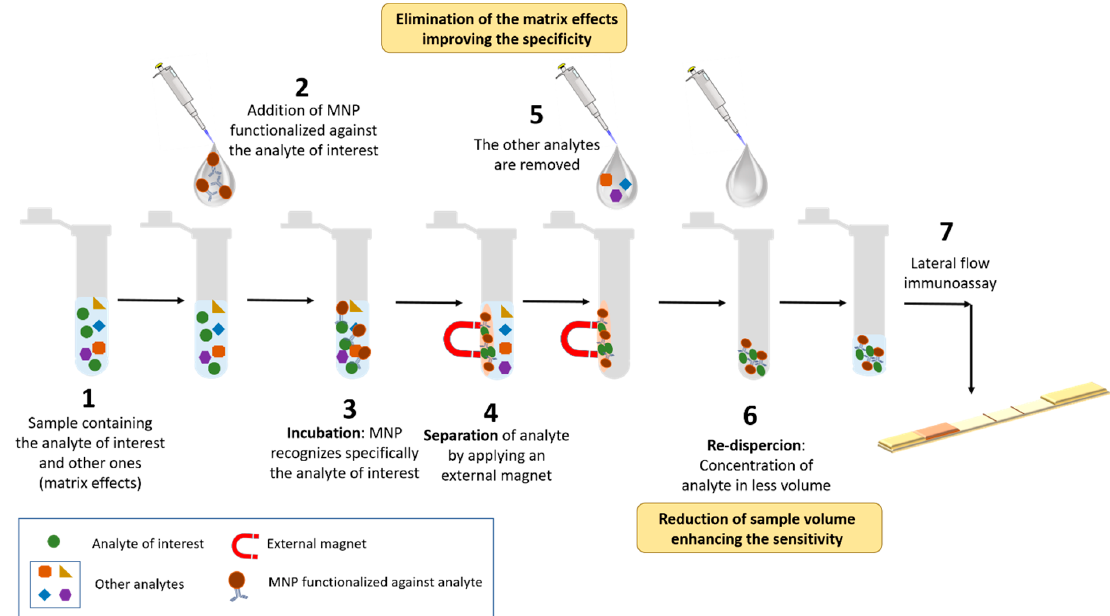
Figure 2. Scheme of the immunomagnetic separation (IMS) procedure.